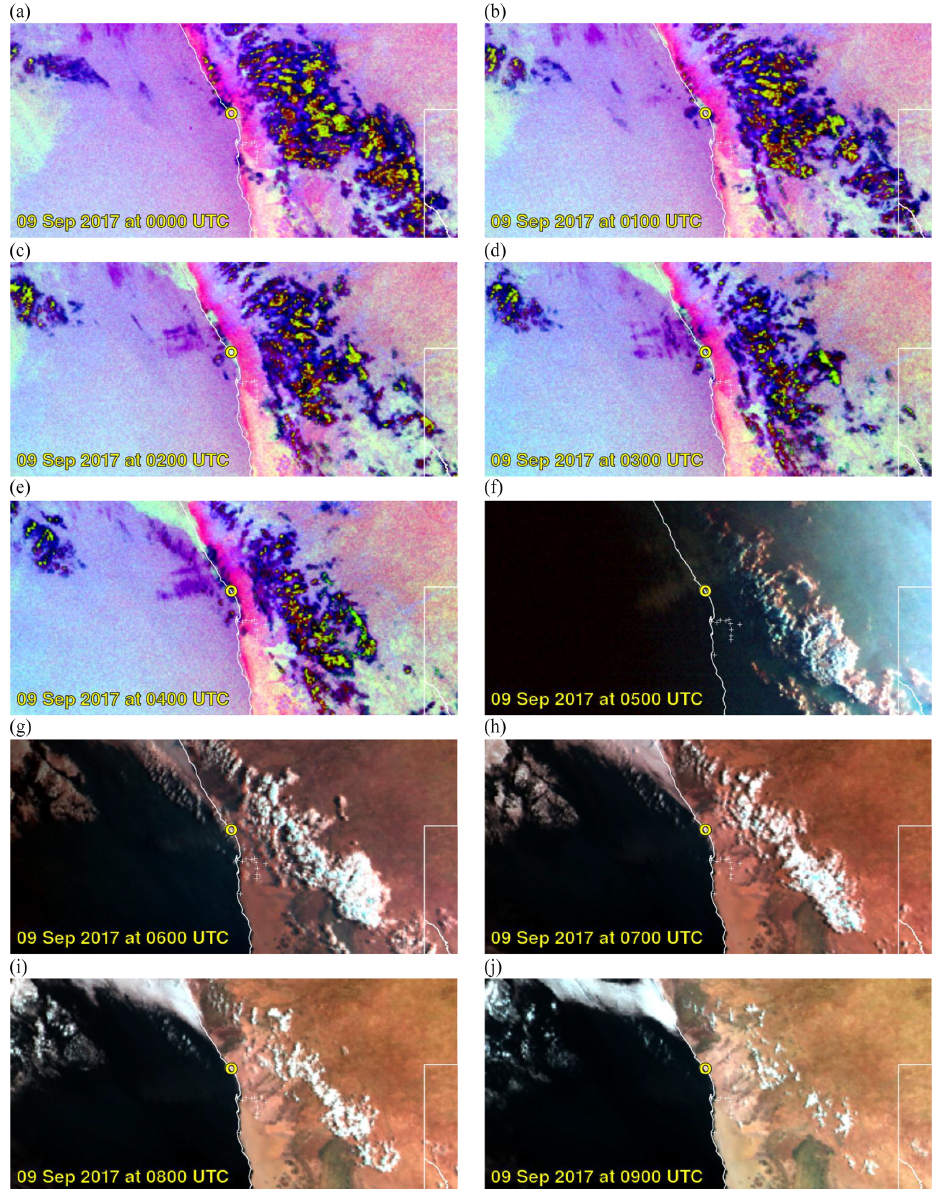
Figure 4. SEVIRI images of night microphysical RGB product (a–e) and day visible channels (f–j) for the fog event on 9 September 2017. The yellow open circle is the study site. The site is UTC + 2. The extent matches the WRF model 3km domain, which extends 1386km (east–west) by 720km